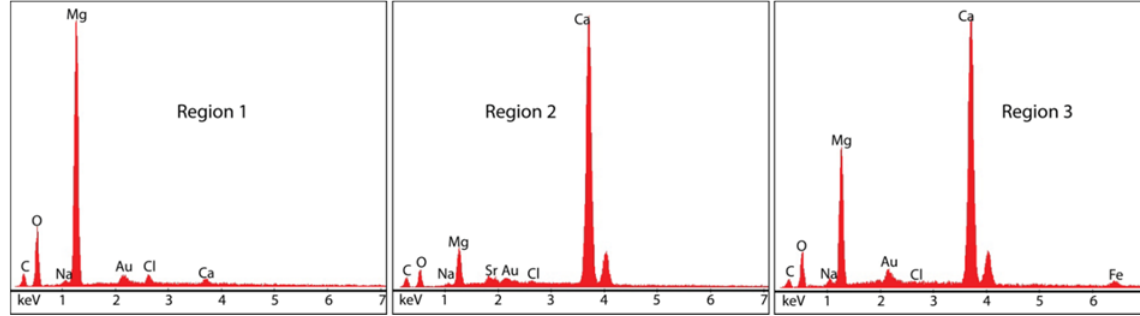
Figure 9. EDX analysis at the locations in Figure 8.